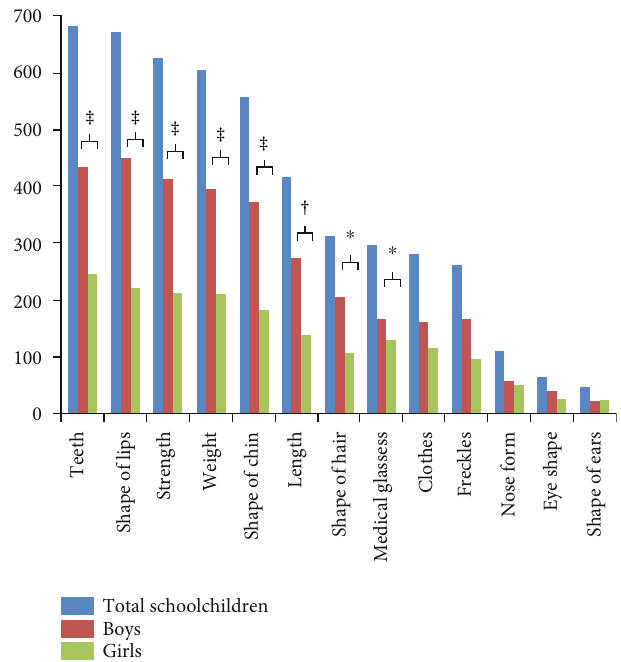
Figure 1: Frequency distribution of physical features reported as targets for victimization according to gender. ∗ p < 0 : 05 , † p < 0 : 01 , and ‡ p < 0 : 001 .